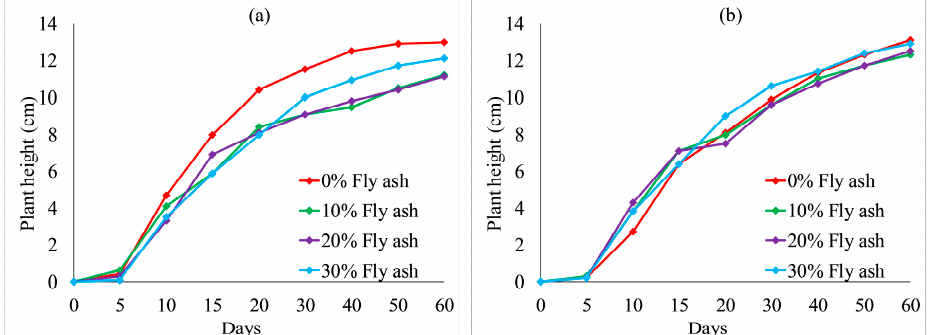
Figure 13. Festuca elata height relative to fly ash content combined with: ( a ) 5% KW fertilizer content; ( b ) 10% KW fertilizer content.